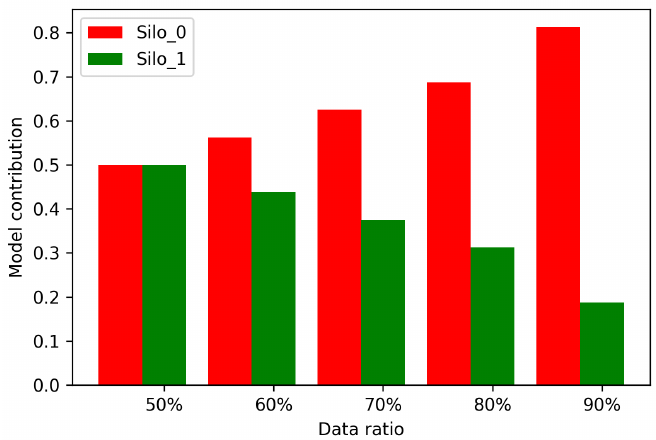
Figure 10. The proportion of model contribution of silos in different data